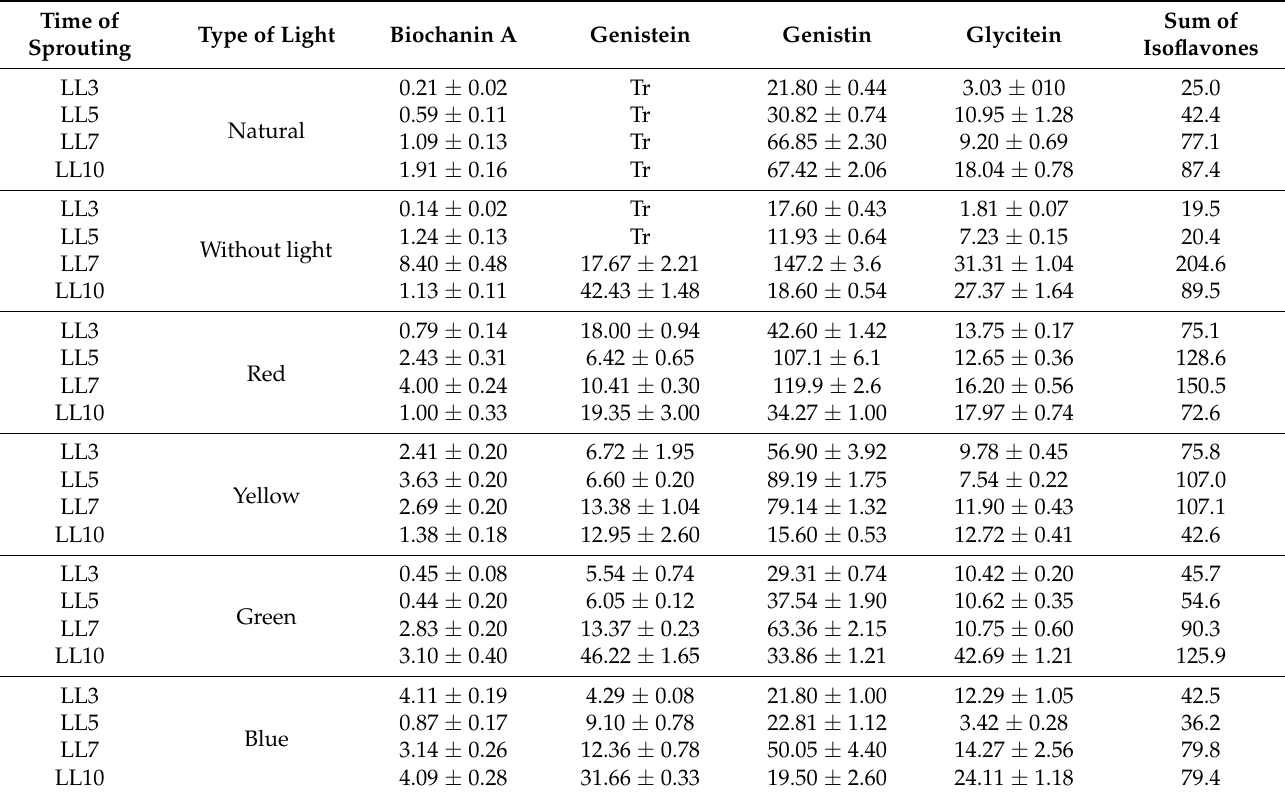
Table 2. Content (mg/100 g dw) of individual isoflavones and their sums in lupin sprouts (LL) harvested in different LED light conditions for 3, 5, 7, and 10 days (mean ± SD; n =